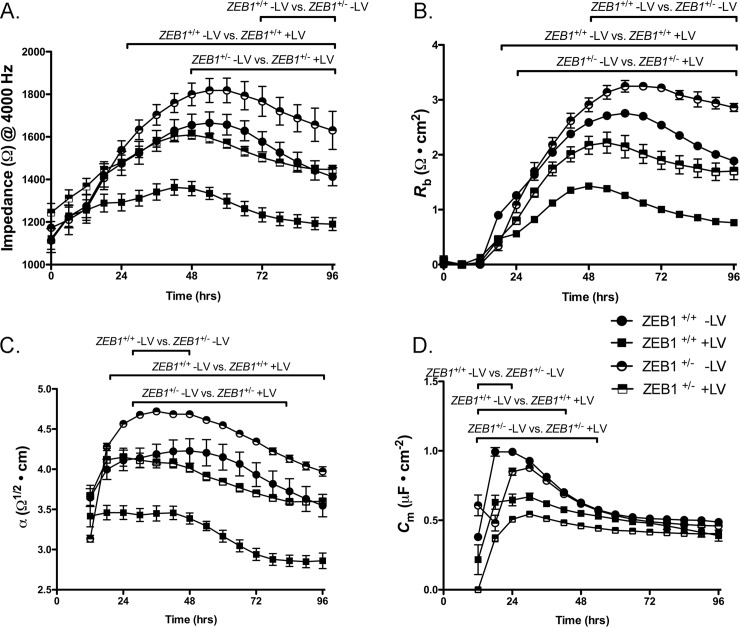
ZEB1 modulates cell barrier function in CEnC.(A) Electrical impedance (Ω at 4000 Hz), a metric of cell barrier function, was measured for up to 96 hours after cells were seeded. (B) Electrical resistance as a result of cell-cell adhesion was modeled from impedance data in (A) and given as Rb (Ω • cm2). (C) Electrical resistance caused by cell-substrate adhesion was modeled from the impedance data in (A) and given as α (Ω1/2 • cm). (D) Cell membrane capacitance, influenced by membrane complexity and morphology, was modeled from the impedance data in (A) and given as Cm (μF • cm-2). Filled circle: wild type CEnC (ZEB1+/+ -LV); half-filled circle: ZEB1 heterozygous CEnC (ZEB1+/- -LV); filled square: ZEB1+/+ cells in which ZEB1 levels were augmented using lentivirus, (ZEB1+/+ +LV); half-filled square: ZEB1+/- CEnC in which ZEB1 levels were reconstituted using lentivirus (ZEB1+/- +LV). Data are plotted over 96 hours as the mean ± SEM (n = 3,4). Comparisons were performed using two-way (genotype and time) repeated measures ANOVA with post-hoc Bonferroni test. Horizontal bars above curves represent time ranges for the indicated comparisons that demonstrated statistical significance, P<0.05.